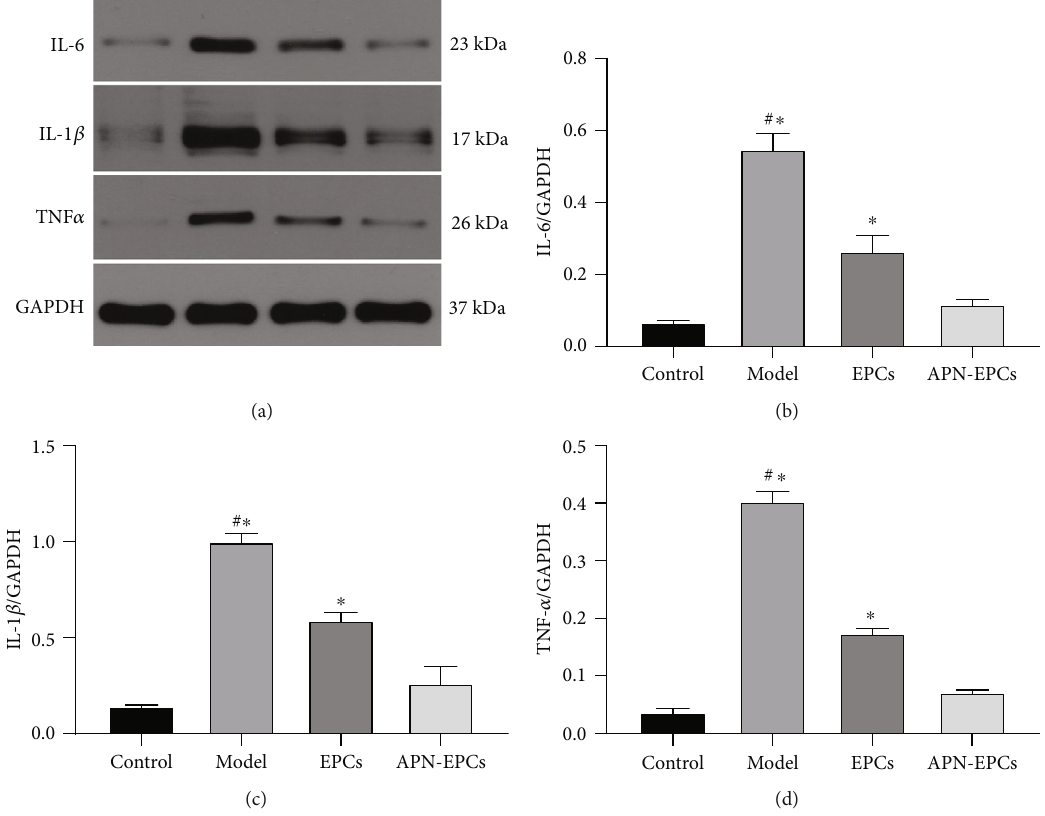
Figure 4: In fl uence of APN-EPC treatment on hippocampal in fl ammatory cytokines of aging rats. (a) Western blotting results of in fl ammatory cytokines. (b) Quantitative result of IL-6. (c) Quantitative result of IL-1 β . (d) Quantitative result of TNF- α . ∗ p < 0 : 05 the model group or the EPCs group compared with the APN-EPC group, # p < 0 : 05 the model group compare with the control group.